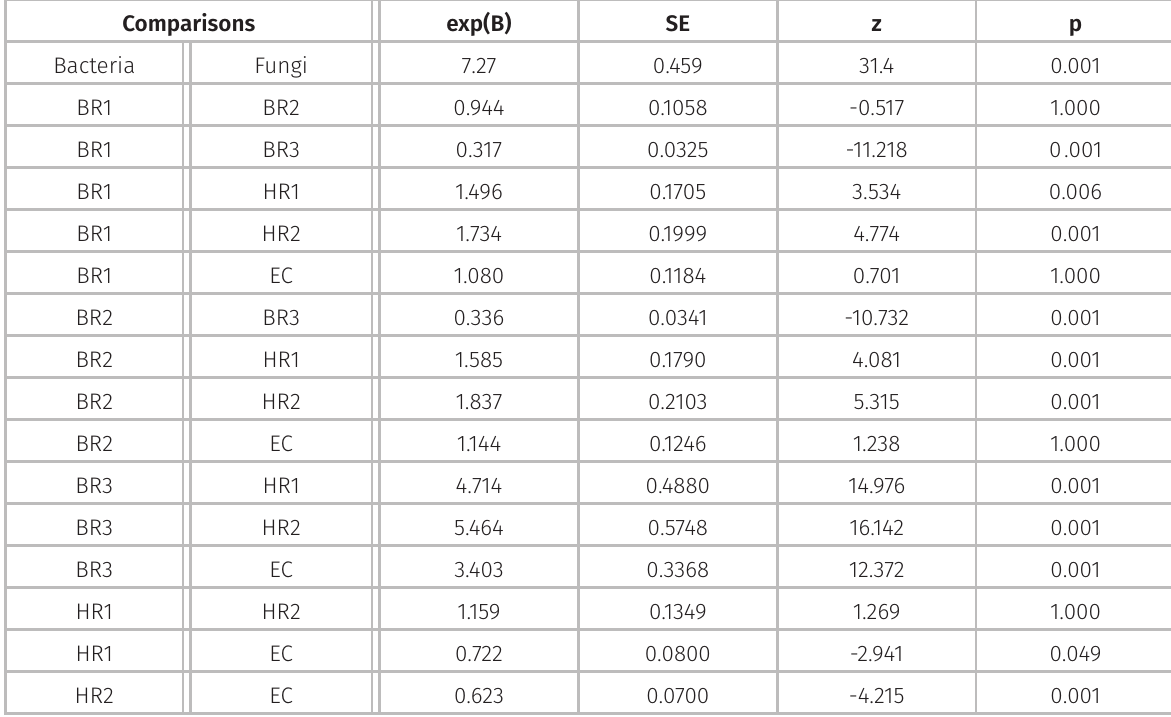
Table II. Analysis of multiple post hoc Bonferroni comparisons of microorganism counts from air samples.